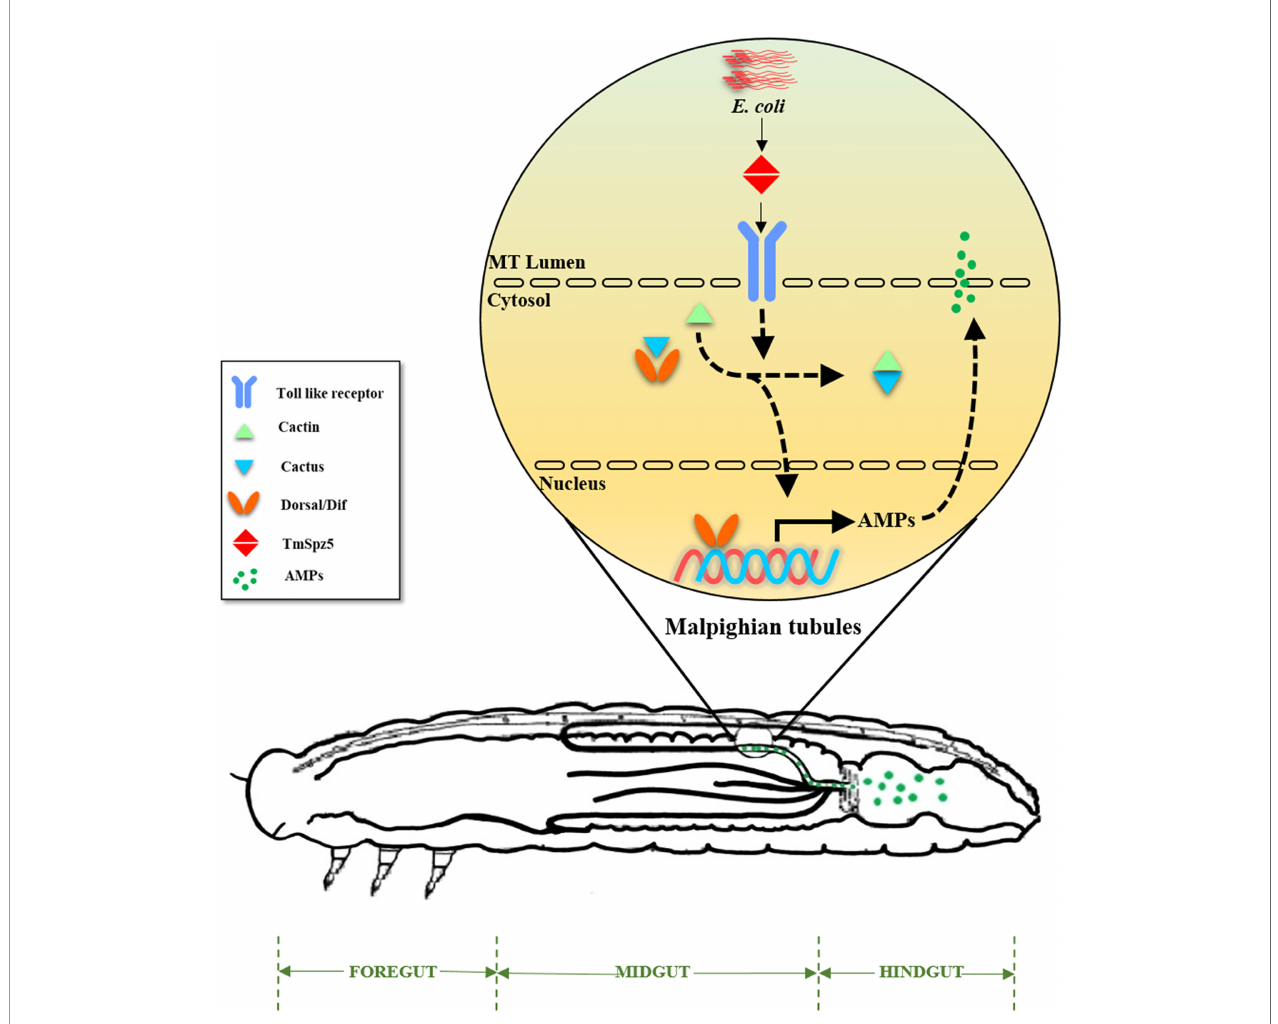
FIGURE 12 | A schematic summary of TmSpz5 positive regulation in antimicrobial peptide production in Malpighian tubules (MTs) of bacterial infected larvae. 10 AMP-encoding genes including TmTen-1 , TmTen-2 , TmTen-4 , TmColA , TmColB , TmAtt-1a , TmAtt-1b , TmAtt-2 , TmTLP-1 , and TmTLP-2 are positively regulated by TmSpz5 upon bacterial infections in MTs and produced peptides along with rest of tubules content, eventually fl ow to